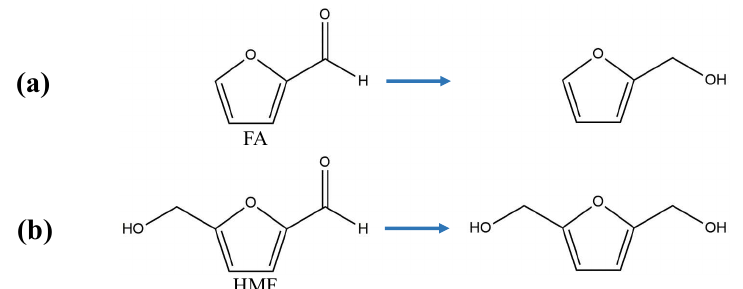
Figure 5. Schematic representation of furan-alcohol derivatives from ( a ) FA and ( b ) HMF that are have been reported in the literature and are catalyzed by alcohol dehydrogenases. HMF : 5-hydroxymethylfurfural, FA : furfural, 2-furaldehyde.